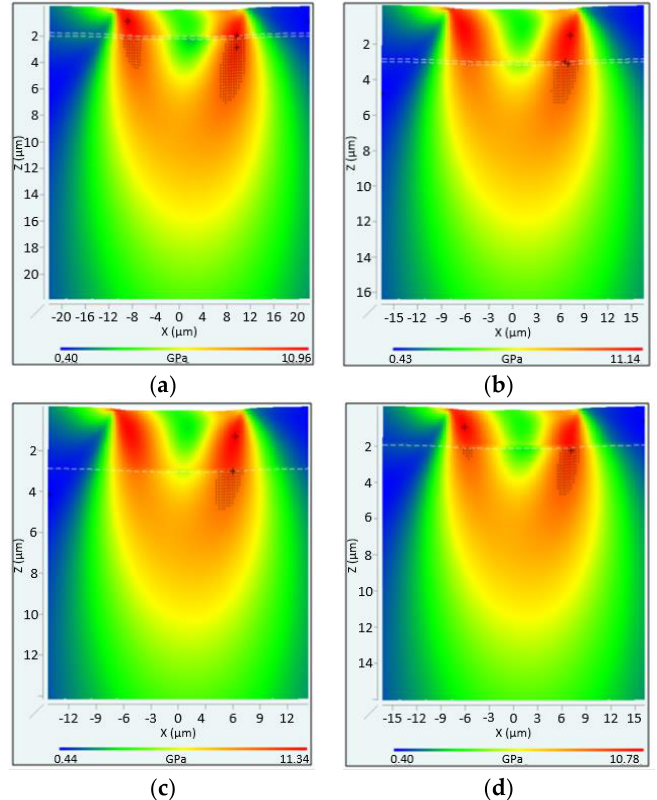
Figure 5. Simulated von Mises stress distributions at L c2 failure for: ( a ) bi-multilayer, 2 µm; ( b ) bi-multilayer, 3 µm; ( c ) monolayer, 3 µm; ( d ) multilayer, 2 µm. The scratch direction is from left to right. Table 5. Simulated maximum von Mises stresses from the micro-scratch test.